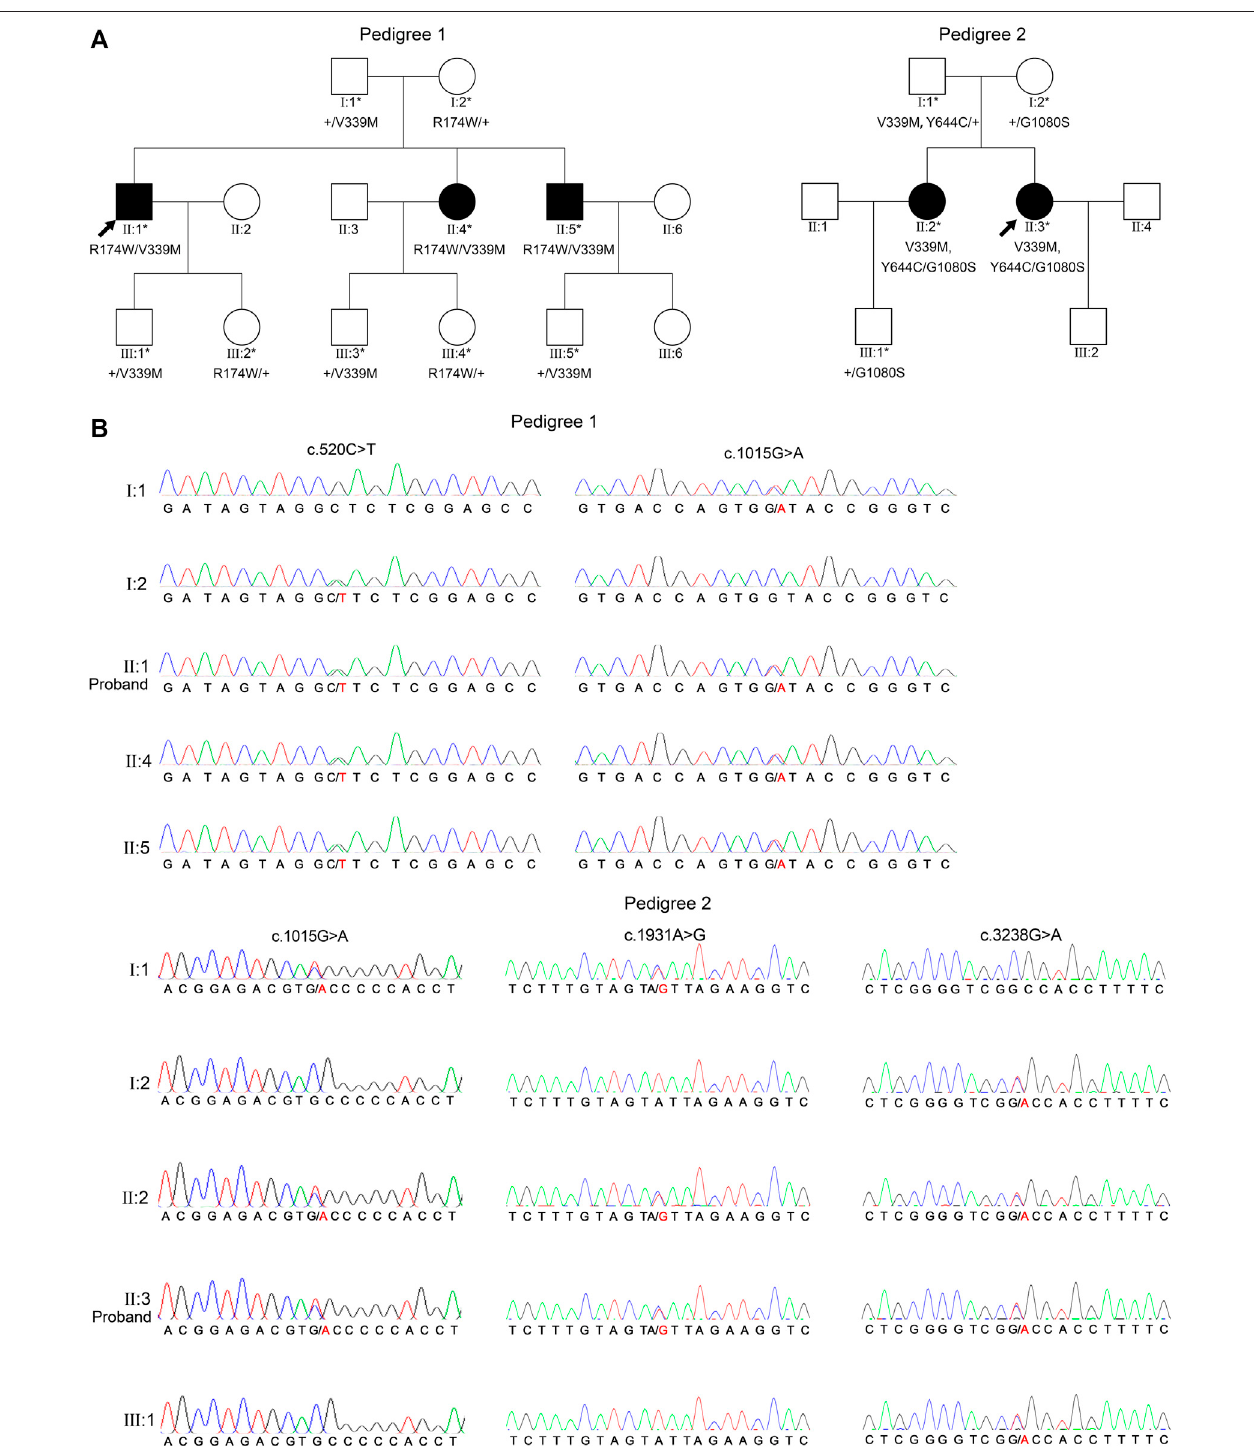
FIGURE 2 | Two PG pedigrees with CPAMD8 variants and Sanger sequencing results of the CPAMD8 gene. (A) The two PG pedigrees described from our research. Round symbols indicate female individuals; square symbols indicate male individuals; black symbols indicate PG patients; arrow marks indicate the proband; asterisks represent subjects involved in genetic research. The plus signs denote reference allele. (B) Sanger sequencing veri fi cation and segregation analysis of biallelic CPAMD8 variants in two PG pedigrees. Variants are denoted in red font. Two different compound heterozygous variants of CPAMD8 were identi fi ed in two PG pedigrees. Abbreviations: PG, pigmentary